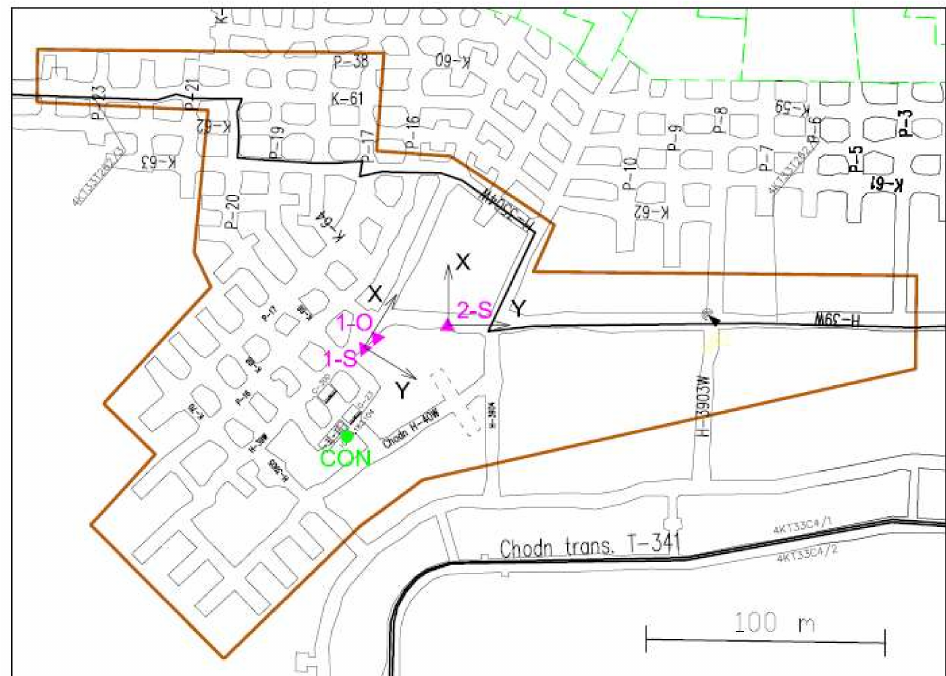
Figure 8. Location of the measuring stations in the C-30D